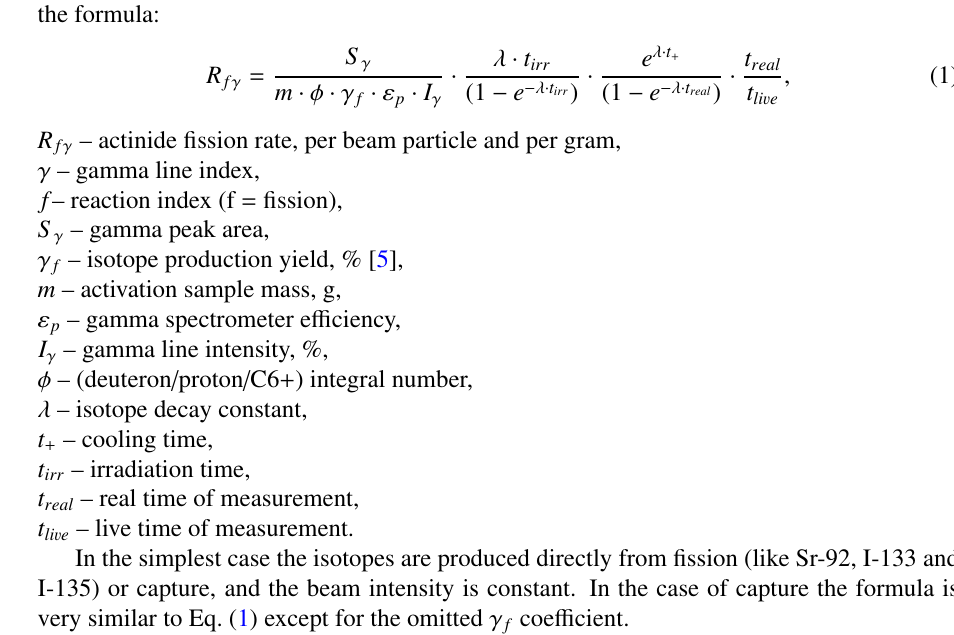
or protons impinged on the uranium core causing nuclei spallation and the production of fast neutrons. The Np-237 sample was located in a side window about 20 cm from the axis of the beam. The spallation neutrons caused U-238 fission which generated a number of neutrons while converting into the Np sample. The Np-237 sample was formed of a disk 21 mm in diameter encapsulated in a U-shaped casing. The gamma spectrum of the sample